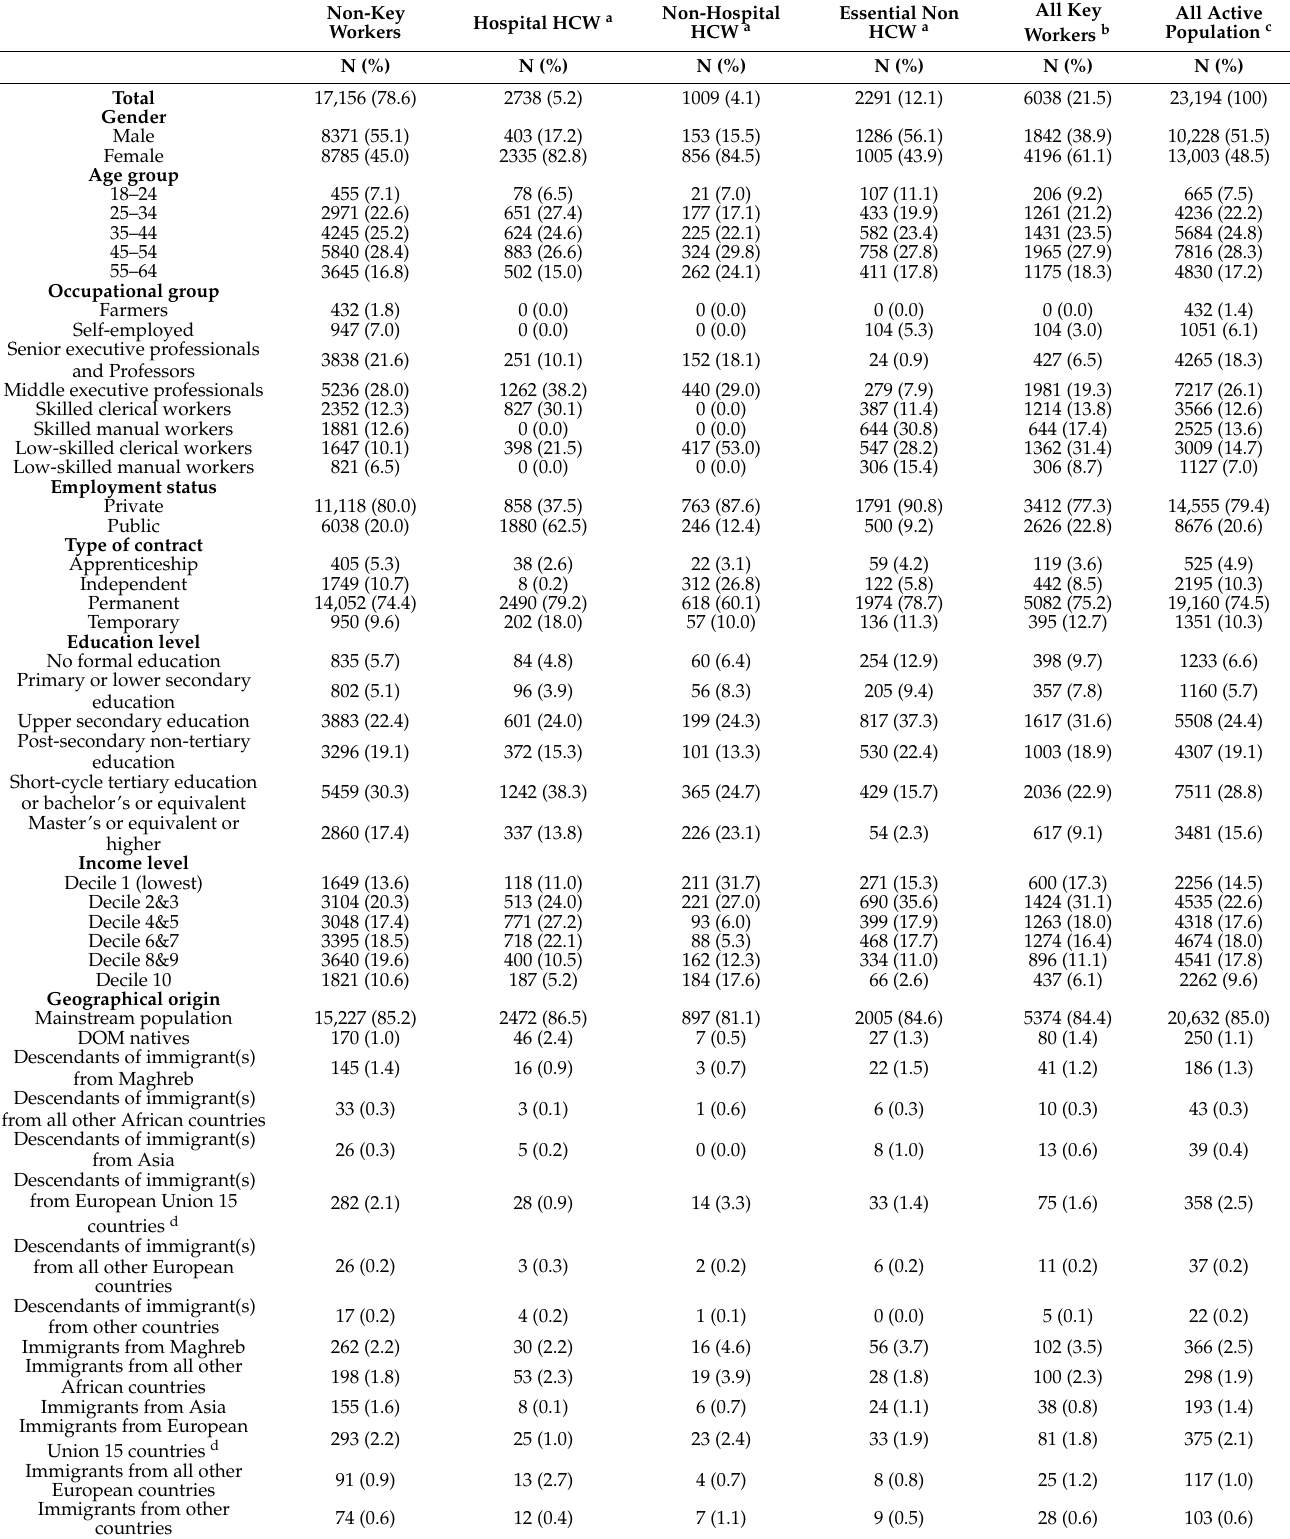
Table 1. Sociodemographic characteristics of the general active population, non-key workers, the three sub-groups of key workers, and all key